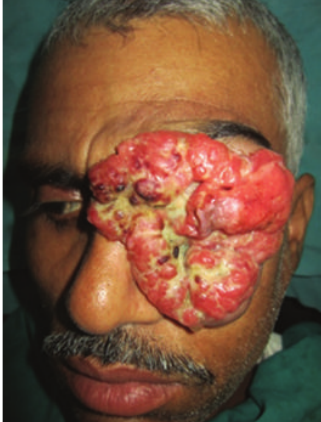
Figure 1: Preoperative lesion.